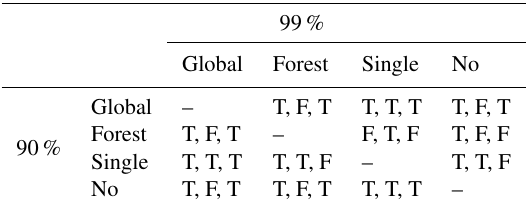
Table 9. Significance of the difference in distribution between re- sults of vegetation scenarios at a 90% and 99% confidence level. Scenario names are shortened. Significance measured by Welch’s t test (Welch, 1947). T (true) indicates a significant difference; F (false) indicates no significant difference. Three indicators per cell are related to the three study areas, ordered as follows: Eriz, Trub and